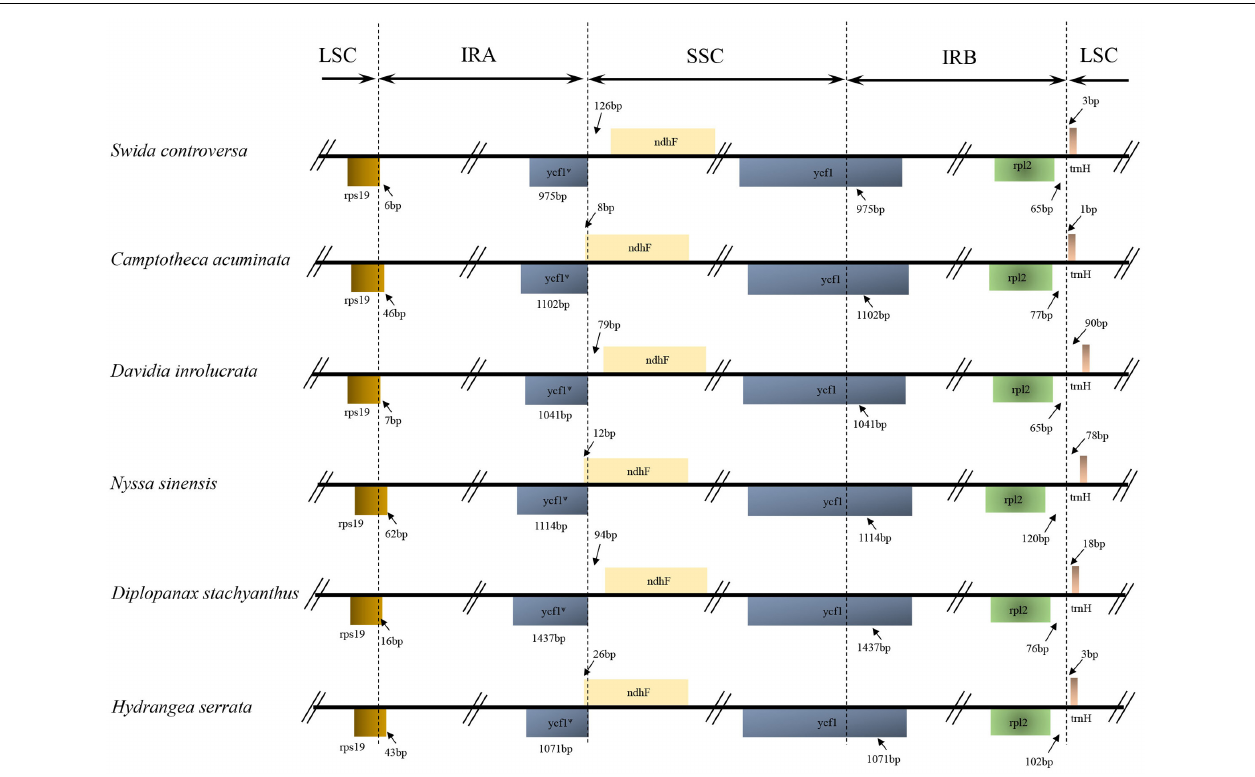
FIGURE 2 | Comparison of the borders of the LSC, SSC, and IR regions among the Camptotheca acuminata , Davidia involucrata , Nyssa sinensis , Diplopanax stachyanthus , Hydrangea serrata , and Swida controversa chloroplast genomes. LSC, large single-copy; SSC, small single-copy; IR, inverted repeat.